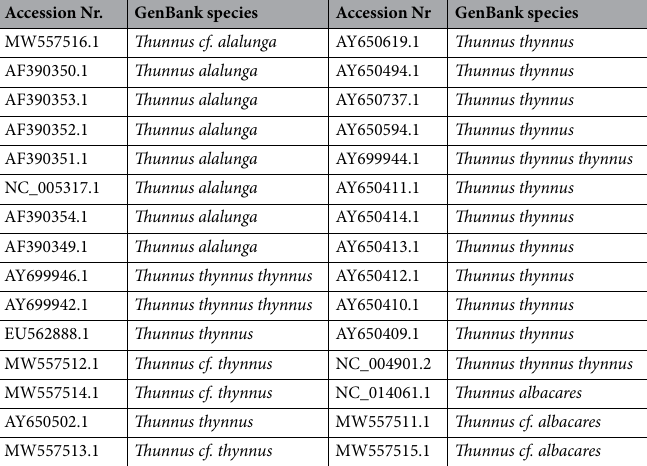
Table 1. Accession numbers and species as they appear in GenBank for the sequences employed to reconstruct the ML tree of Fig. 1.